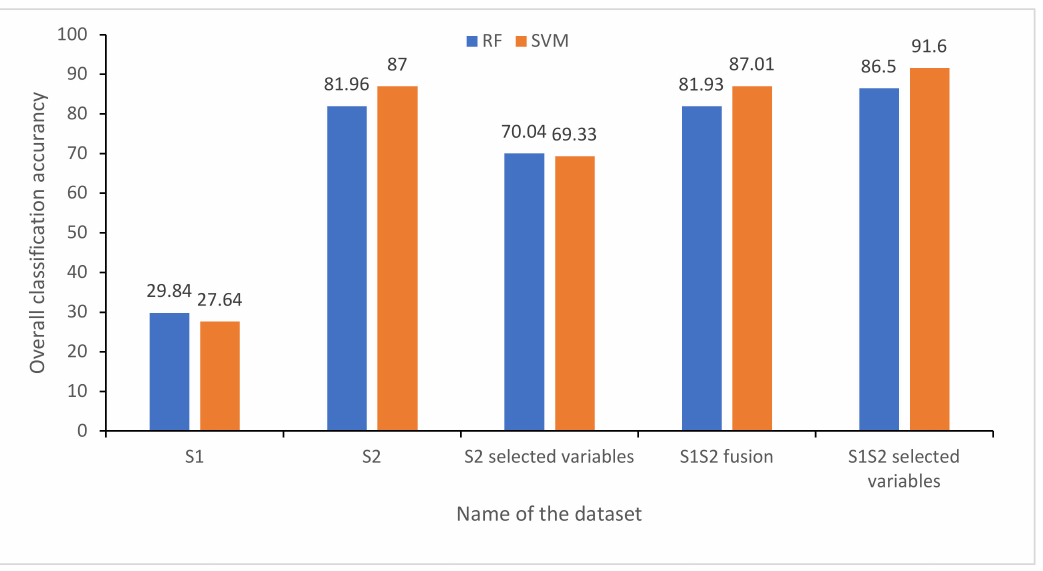
Figure 8. The overall accuracy (OA) obtained by RF (blue) and SVM (orange) classifiers using Sentinel- 1, Sentinel-2, Sentinel-2 selected variables, S1S2 fusion, and S1S2 selected variables in mapping tree crop species and other existing land